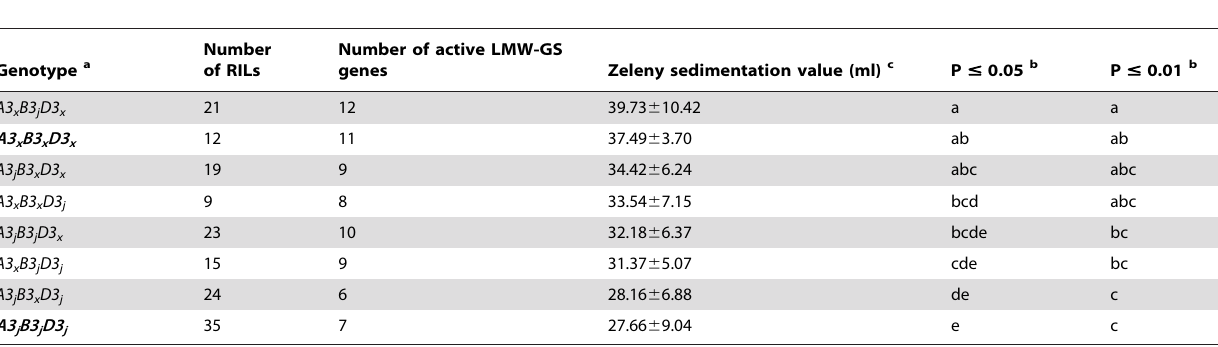
Table 3. Statistical analysis of the Zeleny sedimentation values (means 6 SD) of eight genotypes among 152 RIL lines derived from a cross between Xiaoyan 54 and Jing